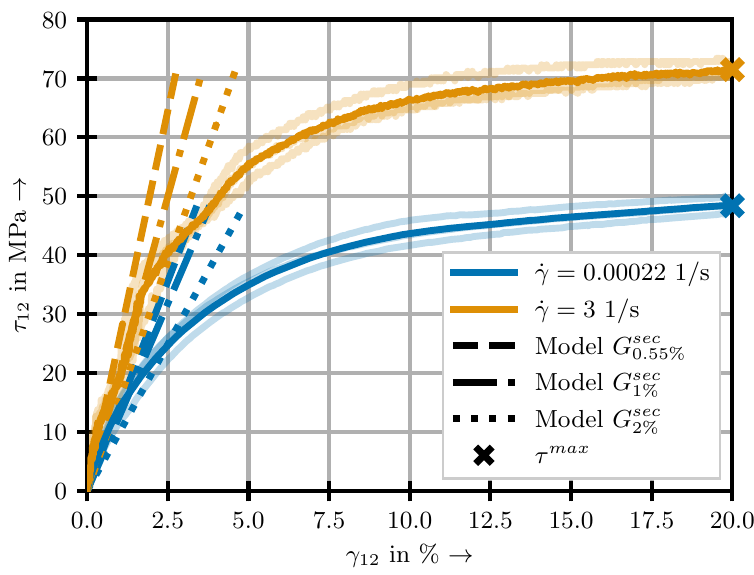
Figure 6. MaS model predictions for secant moduli and maximum shear stress, exemplary for the 12-configuration at lowest and highest investigated strain rates.